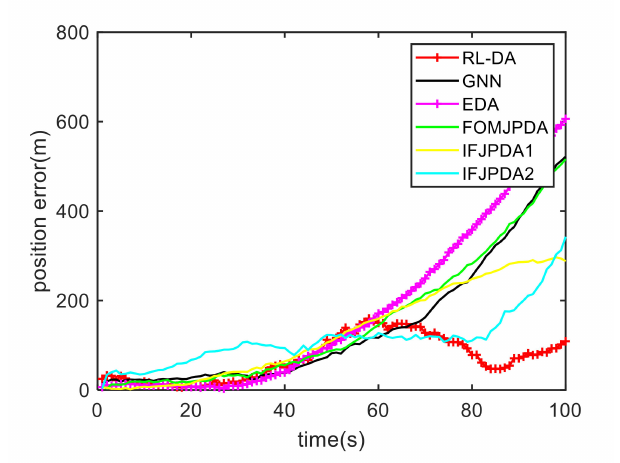
Figure 16. True and estimated tracks using the RL-JPDA in Case 2.